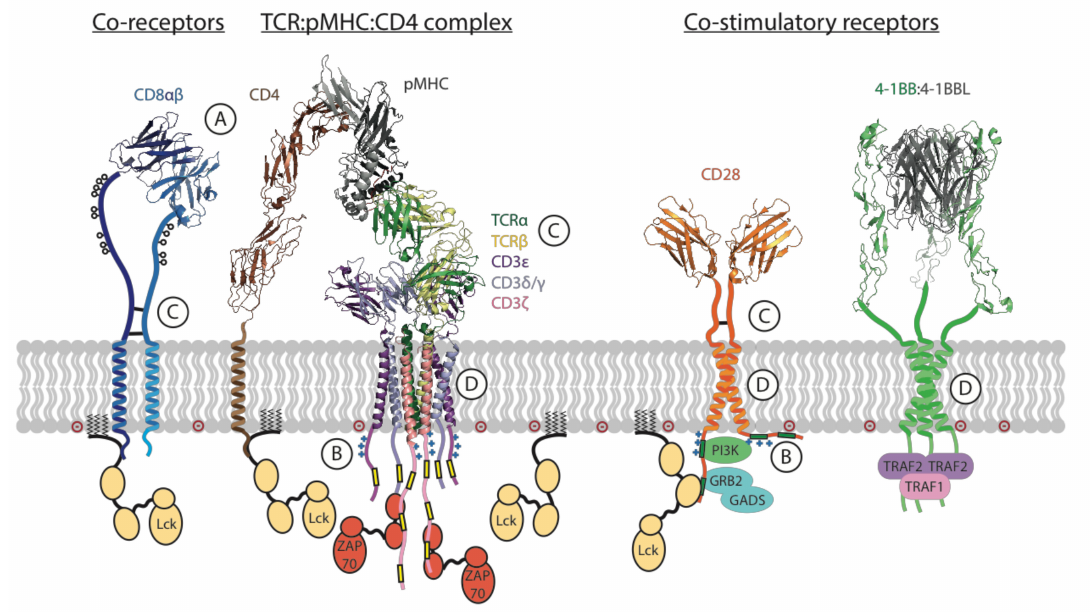
Figure 1. T cell activation following TCR recognition of stimulatory pMHC requires sensitivity enhancing co-receptor engagement of MHC (CD4 or CD8 αβ ) as well as co-stimulatory signals from constitutively expressed CD28 and several TCR induced co-stimulatory molecules (4-1BB depicted here). Yellow boxes represent ITAMs, green boxes represent non-ITAM stimulatory motifs. ( A ) Co-receptors CD4 / CD8 αβ engage MHC, dramatically increasing TCR sensitivity. ( B ) Positively charged tails interact with negatively charged lipid head groups. ( C ) Stalk cysteines facilitate interchain disulfide crosslinking. ( D ) Homo / hetero-typic TM interactions are vital to immunoreceptor assembly and function. Protein data bank (PDB) codes of structures shown in this figure: CD8 αβ 2ATP, CD4 / pMHC / TCR αβ 3TOE, TCR 6XJR (TCR αβ from 3TOE aligned against TCR αβ chains in 6XJR using pymol, 3TOE TCR αβ chains not shown), CD28 1YJD, 4-1BB / 4-1BBL